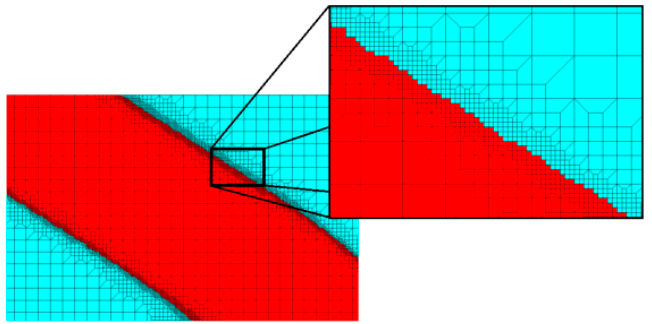
Figure 7. Mesh refining on the boundaries of the structure.